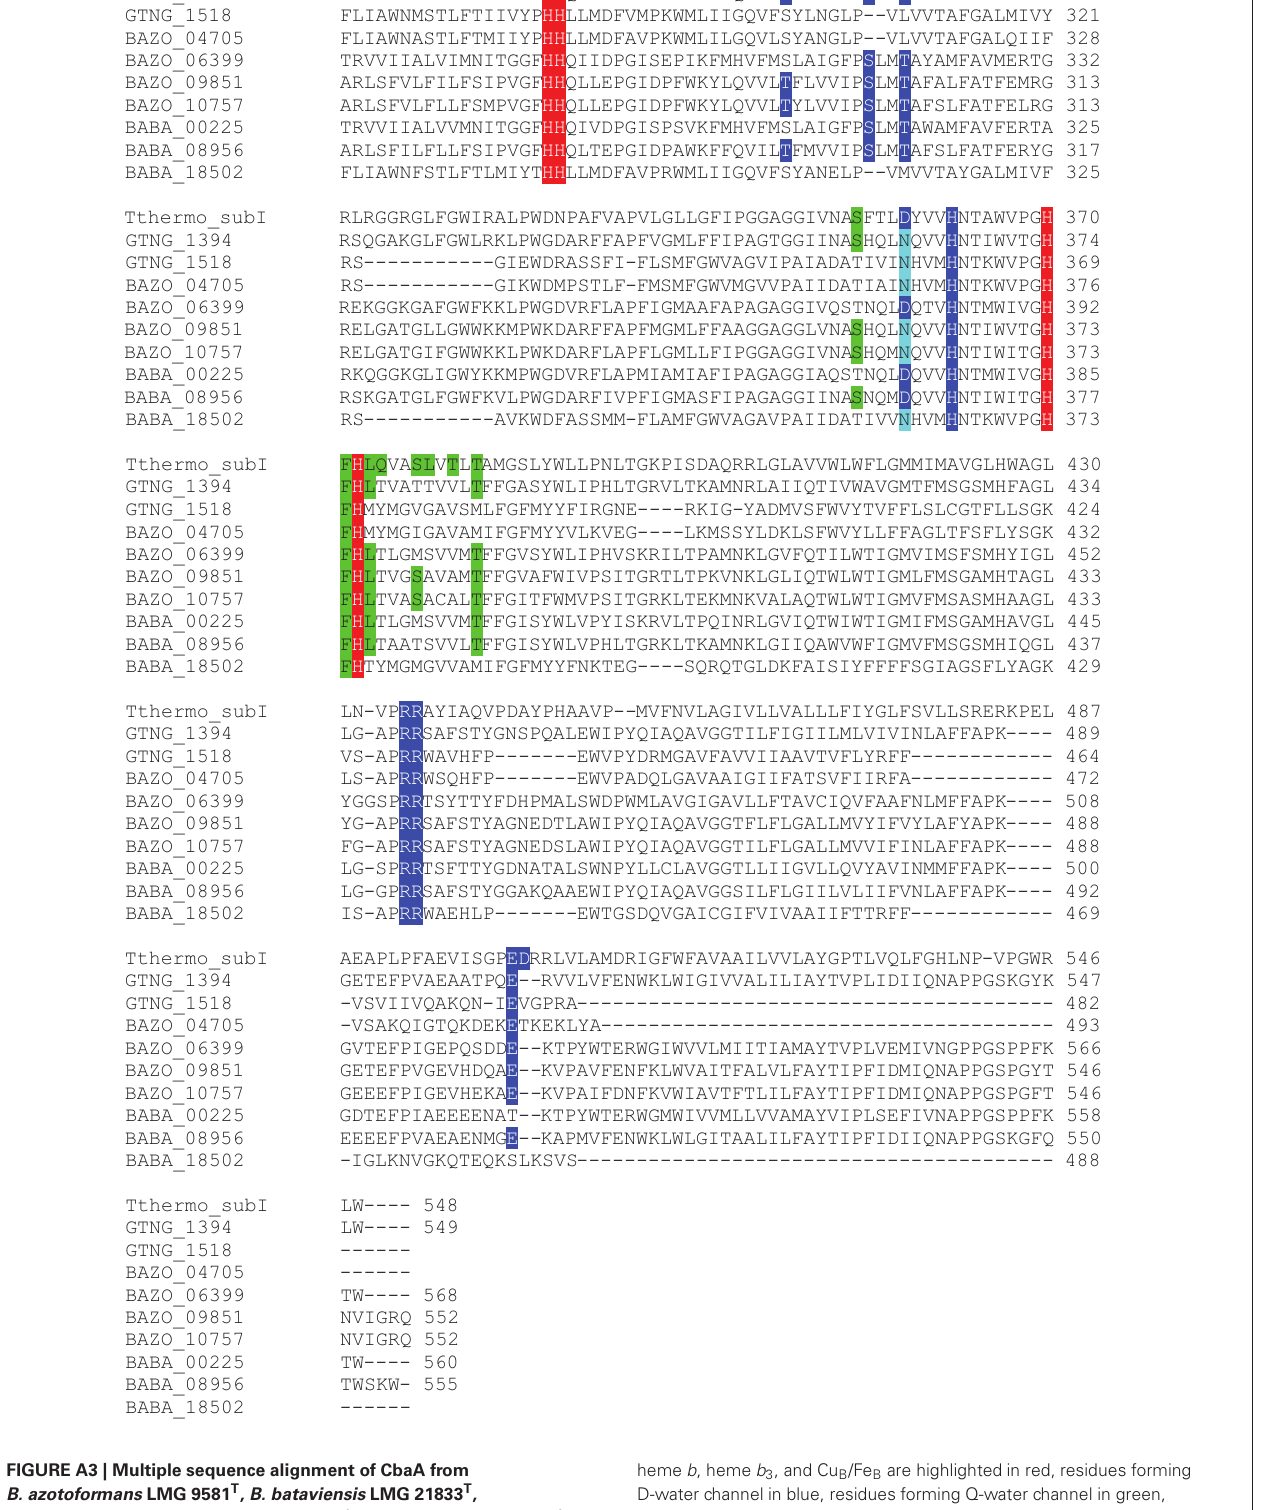
FIGURE A3 | Multiple sequence alignment of CbaA from B. azotoformans LMG 9581 T , B. bataviensis LMG 21833 T , Geobacillus thermodenitrificans NG80-2 (GTNG_1394; GTNG_1518), and. T. thermophilus (PDB 3EH3). Amino acids involved in the binding of